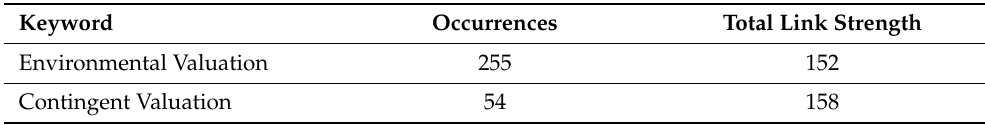
Table 5. Keyword co-occurrences in environmental valuation